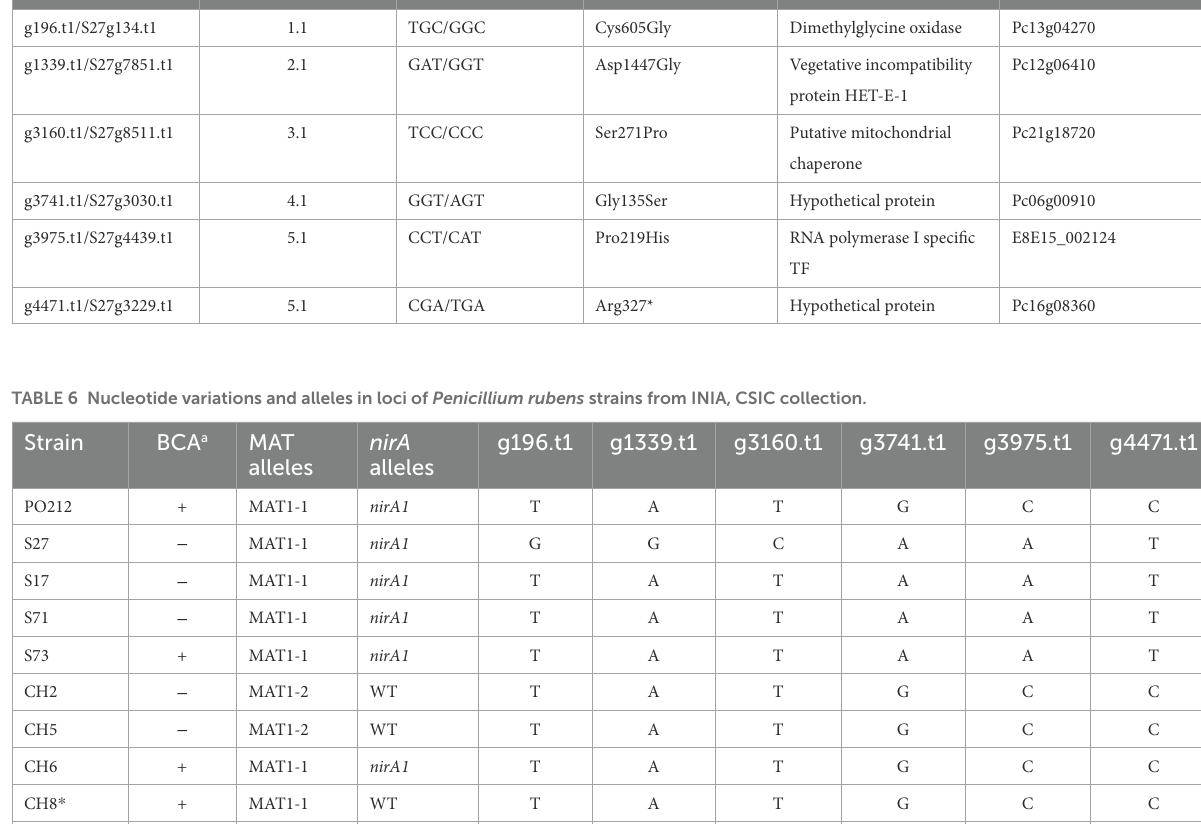
TABLE 5 List of the genes whose sequences present variations between PO212 and S27 strains and the affected amino acid. Coding region change PO212/ S27